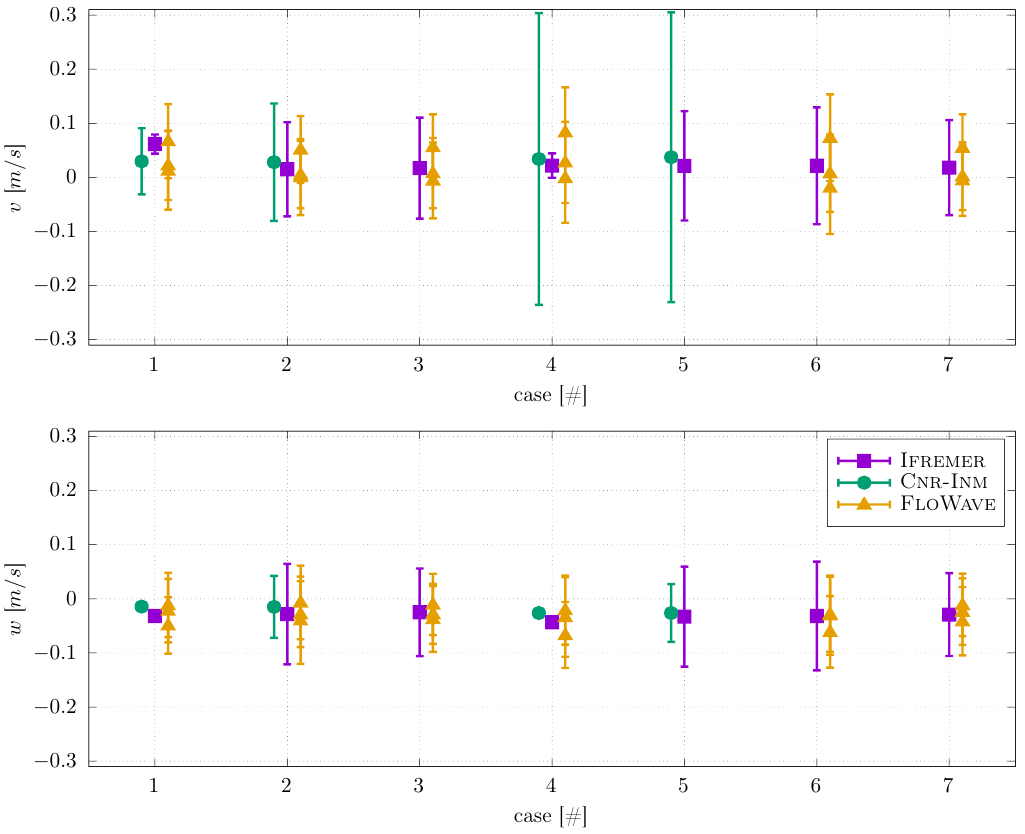
Figure 10. Average and standard-deviation of the transverse v and vertical w span-wise components of the velocity measured with ADV at z = 0 ( P 0 , P 3 and P 4 ) versus case numbers.